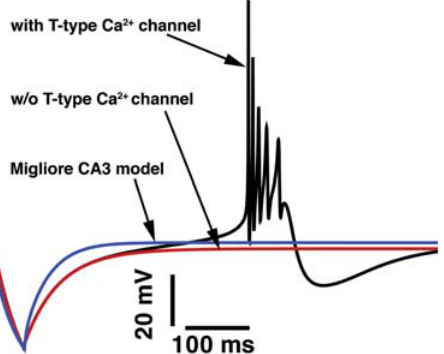
Figure 3. Rebound bursting in the CA3 model neuron . Rebound bursting responses of the CA3 model neuron to a hyperpolarizing current injection (0.03 nA for 50 ms) to mimic inhibitory GABA synaptic inputs. Note the initial hyperpolarization of the membrane and the subsequent rebound before action potential firing (black line). Without T-type Ca 2 + channels, the model fails to rebound (red line). The Migliore CA3 model is also unable to generate rebound excitation in response to a hyperpolarizing current injection (0.3 nA for 50 ms, blue line).